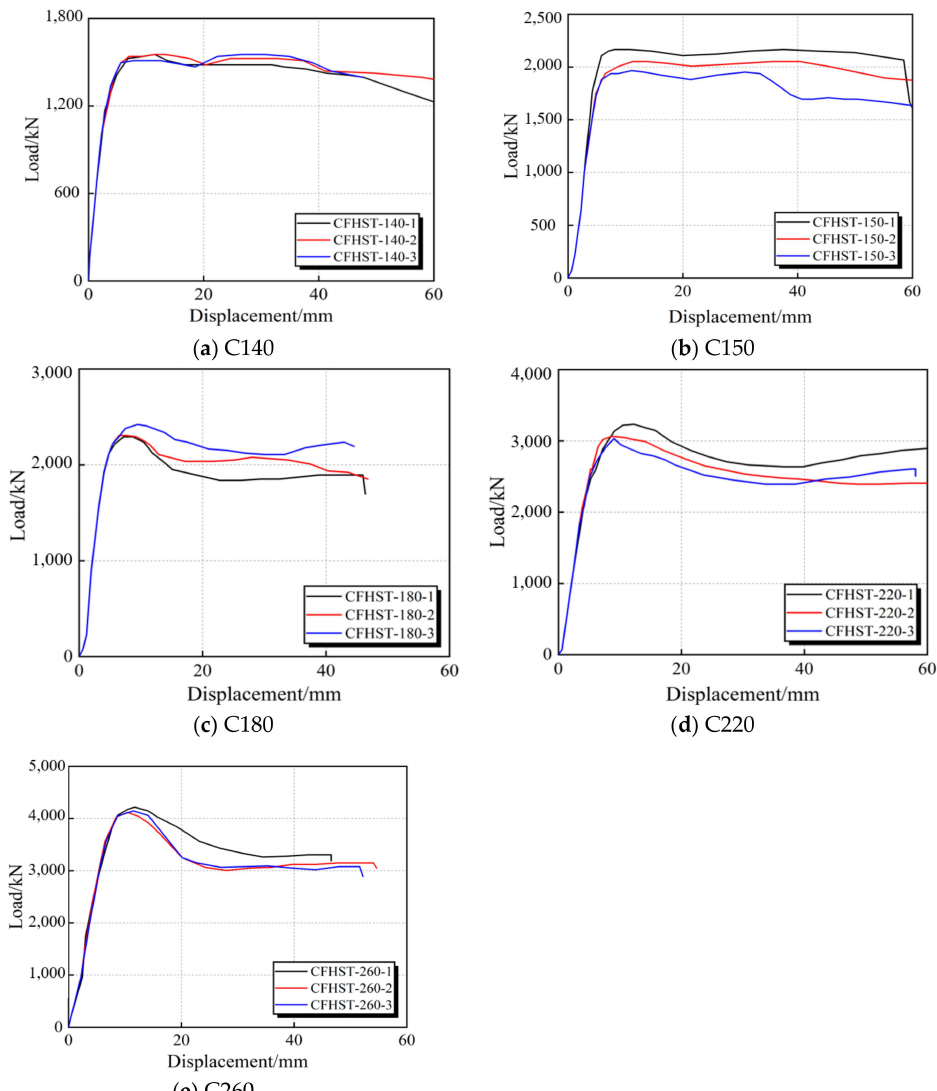
Figure 6. Axial load–displacement response of tested